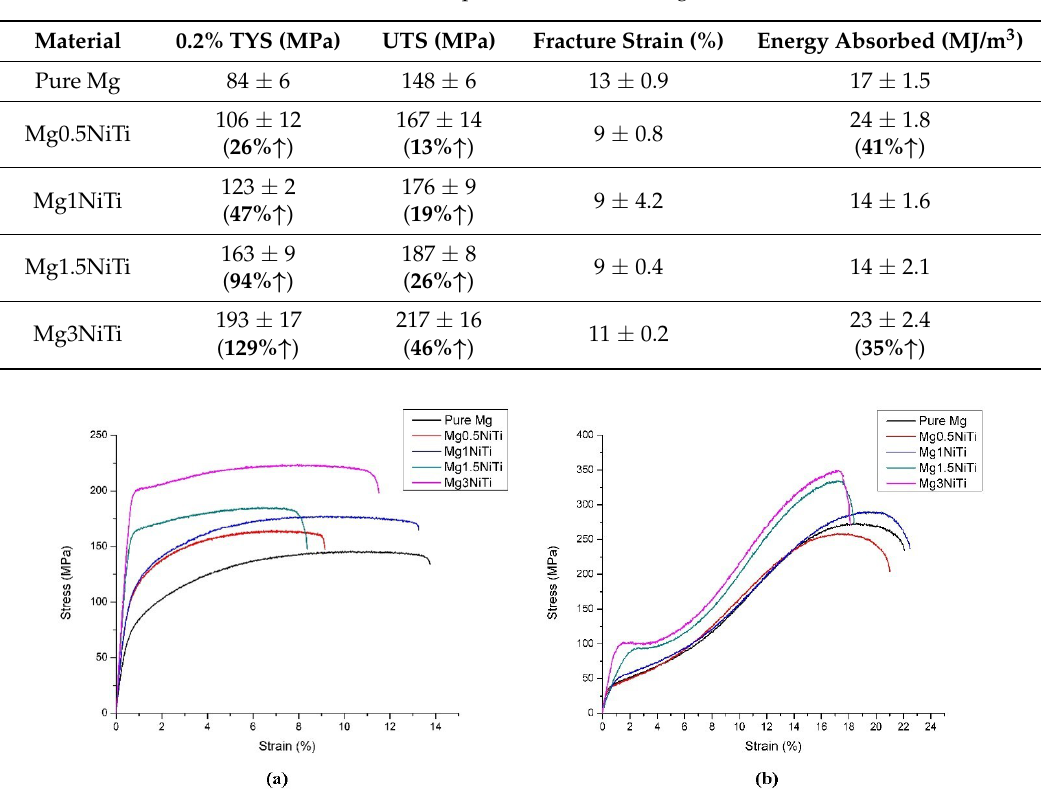
Figure 4. ( a ) Tensile and ( b ) compressive stress vs. strain curve obtained for different Mg-NiTi nanocomposites.